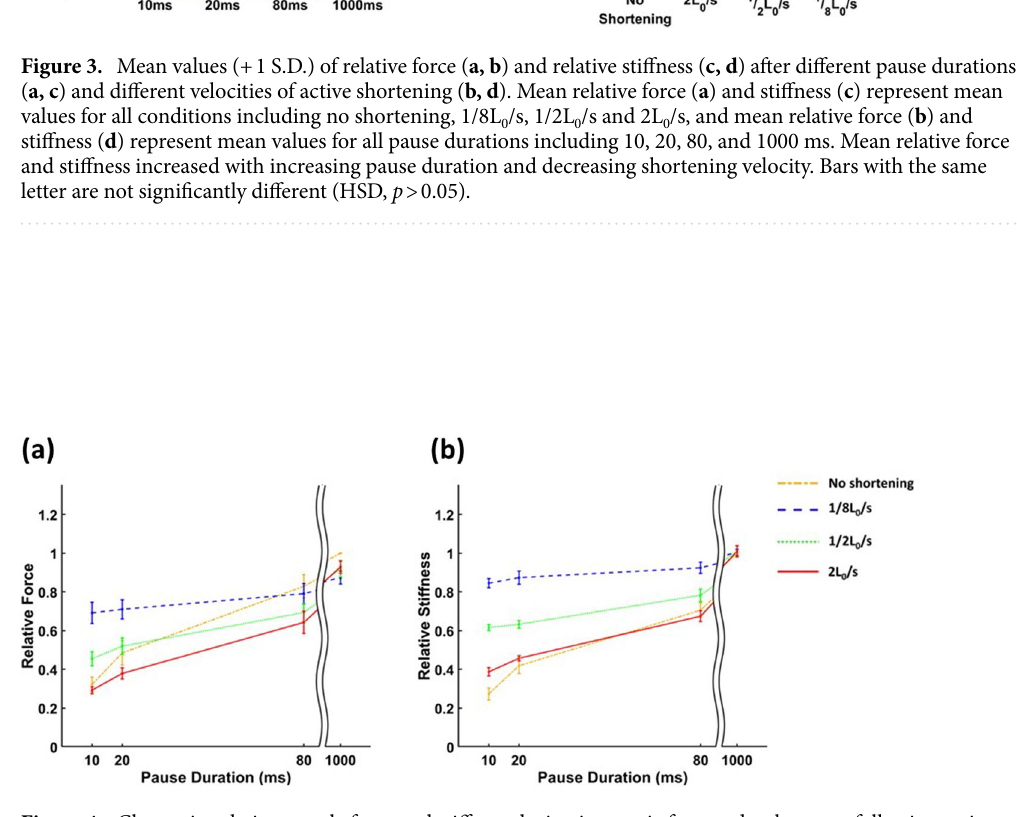
Figure 4. Change in relative muscle force and stiffness during isometric force redevelopment following active shortening at different velocities. Data points (n = 7 muscles per group) are means across muscles with error bars representing S.D. ( a ) Relative force increases with increasing pause duration. The rate of increase varies with shortening velocity. ( b ) Relative stiffness increases with increasing pause duration and shortening velocity affects the stiffness vs. pause duration relationship. The slope of the relationship increases with increasing shortening